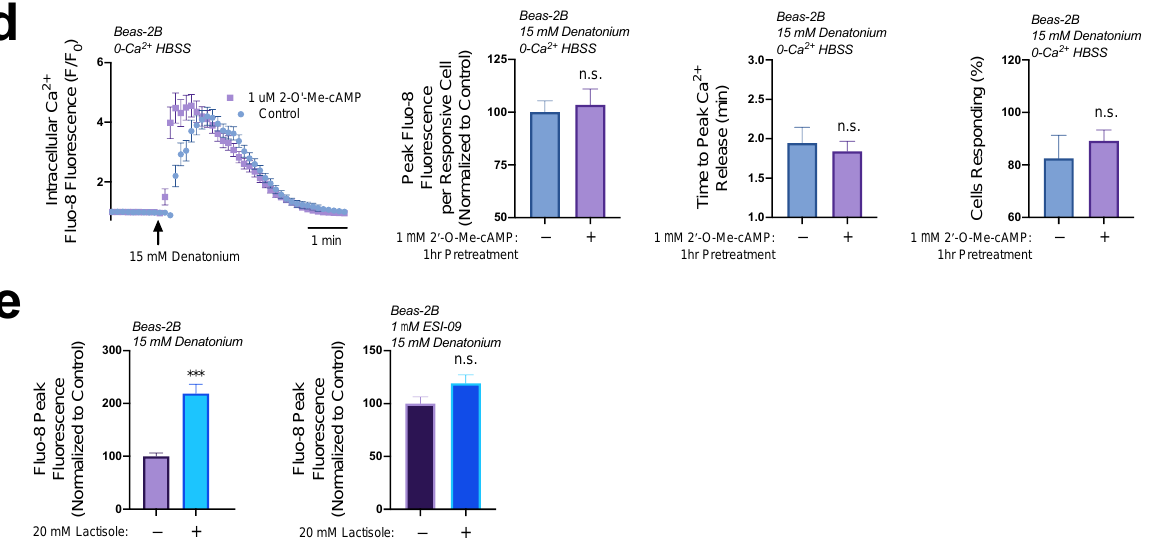
Figure 4. EPAC regulates ER Ca 2+ content and efflux. ( a ) The 20 mM lactisole treatment caused a sustained increase in cAMP as detected by Epac-S-H74 biosensor. ( b ) EPAC agonist 2 (cid:48) -O-Me-cAMP (1 µ M, 1 h pretreatment) increased peak ER Ca 2+ release by 25%, increased the magnitude of the initial linear slope by 50% but had no effect on total ER Ca 2+ content while antagonist ESI-09 (1 µ M, 1 h pretreatment) decreased peak ER Ca 2+ release by 25%, decreased the magnitude of initial linear slope by 35%, and reduced total ER Ca 2+ content by 30%. ( c ) EPAC agonist 2 (cid:48) -O-Me-cAMP (1 µ M, 1 h pretreatment) increased denatonium-induced Ca 2+ elevations by 1.8-fold, reduced the time it took to reach maximal Ca 2+ elevations by 30 s, and increased the Ca 2+ released per cell by 67%. In a similar experiment as ( d ) Beas-2Bs preincubated with 2 (cid:48) -O-Me-cAMP (1 µ M, 1 h) were stimulated with 15 mM denatonium in 0-Ca 2+ HBSS, revealing no significant changes in peak Ca 2+ elevations per cell or time to peak Ca 2+ elevation. ( e ) The 20 mM lactisole (1 h pretreatment) increases denatonium-induced Ca 2+ release by ~200% but is blocked by EPAC inhibitor ESI-09 (1 µ M for 1 h pretreatment). Traces are representative of ≥ 3 experiments. Bar graphs containing 2 comparisons were analyzed via t -test; bar graphs containing >2 comparisons were analyzed via ANOVA using Dunnett’s post-test for multiple comparisons * p < 0.05, ** p < 0.01, *** p < 0.001, “n.s.” represents no significance. Using thapsigargin to measure ER Ca 2+ content as described above in Section